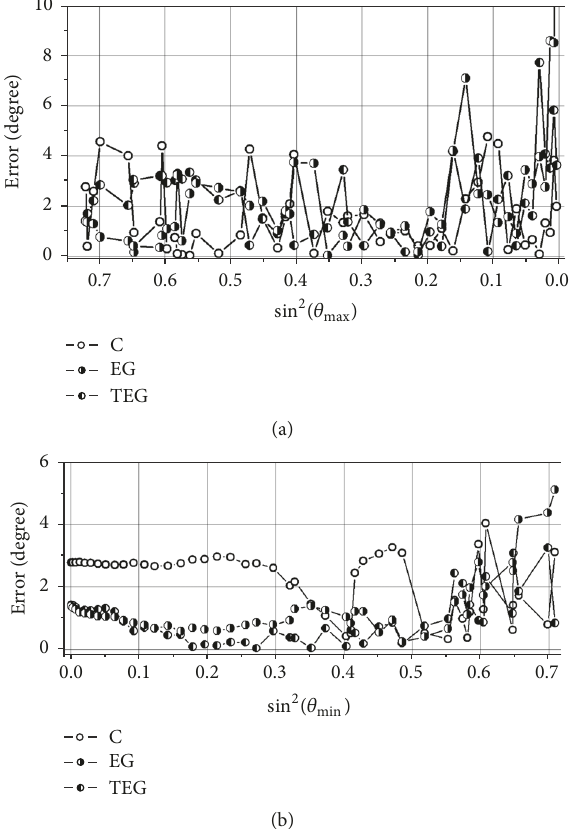
Figure 10: Error for seismograms with noise, variant 𝑉 𝑃3 = 4800 : (a) the fixed minimum offset and (b) the fixed maximum offset. with noise, obtained for the case of viscoelastic target layer (with attenuation) to test the best AVOA method from [5] and compare it with the best QVOA techniques.